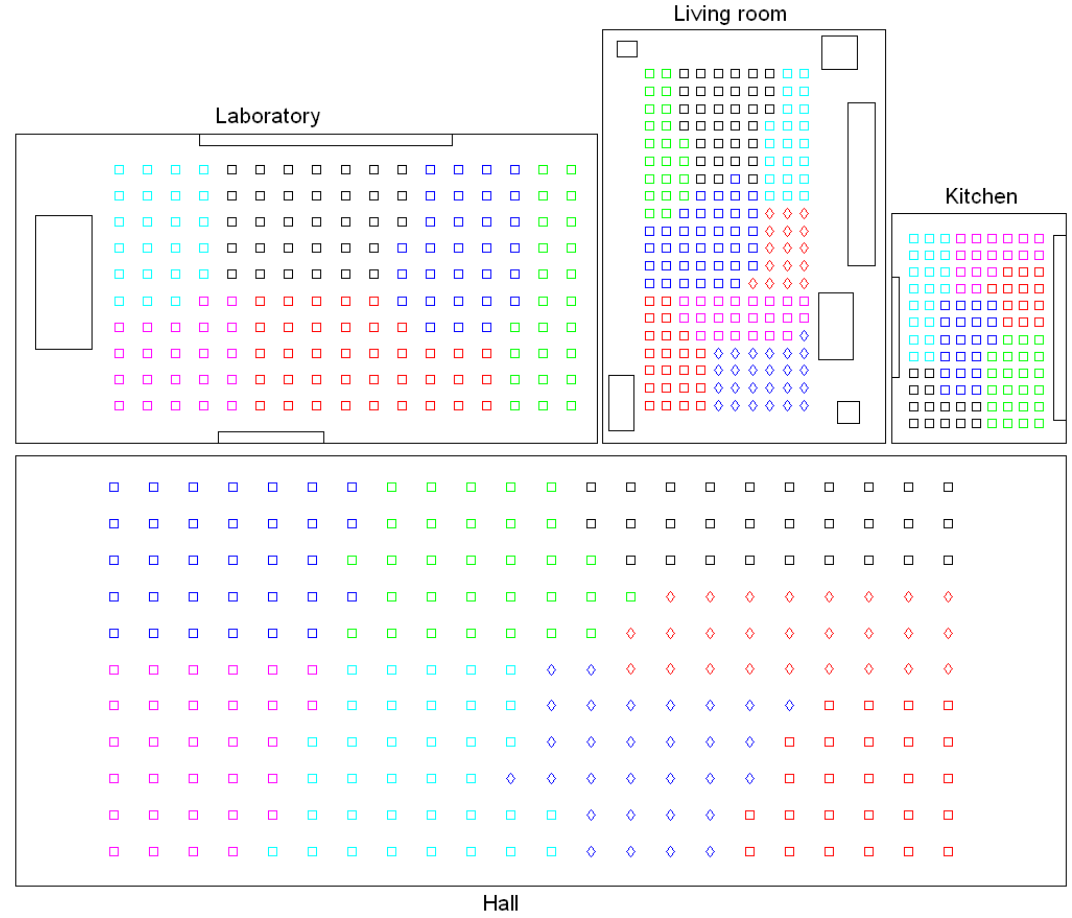
Figure 14. Results of the intermediate-level mapping using gist with m = 16 masks and k 6 = 4 horizontal blocks. Bird’s eye view of the four rooms of the Bielefeld set. The colors of the capture points indicate the cluster they belong to.